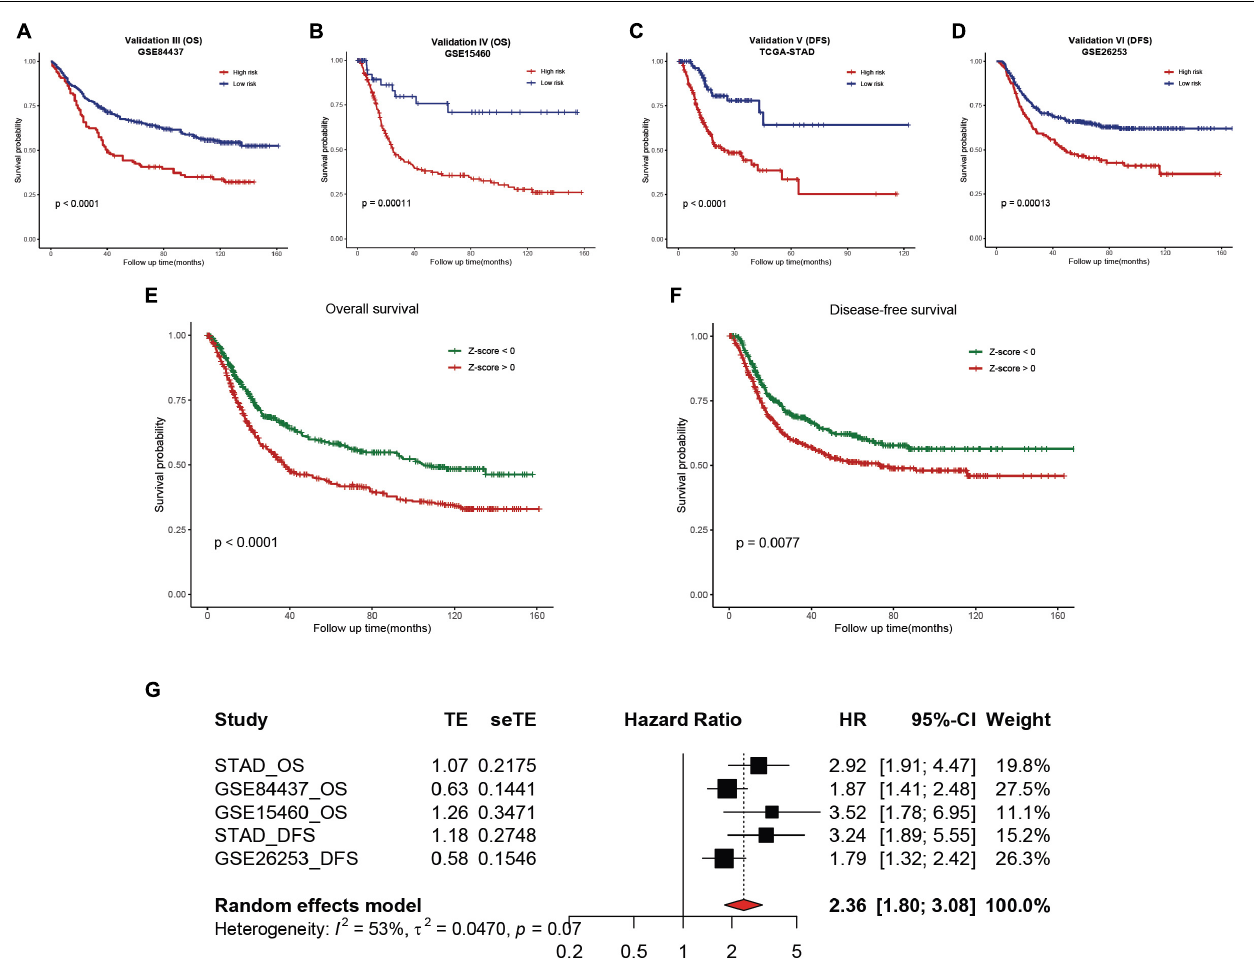
FIGURE 11 | External validation of the established hsa-miR-100-5p-related prognostic signature. (A,B) Kaplan–Meier analysis of the low- and high-risk groups on overall survival in GSE84437 (A) and GSE15460 (B) . (C,D) Kaplan–Meier curves of the low- and high-risk groups on disease-free survival in TCGA-STAD (C) and GSE26253 (D) . (E,F) Kaplan–Meier survival analyses on overall survival (E) and disease-free survival (F) in pooled cohorts. (G) Meta-analysis was performed to calculate the pooled HR of the prognostic